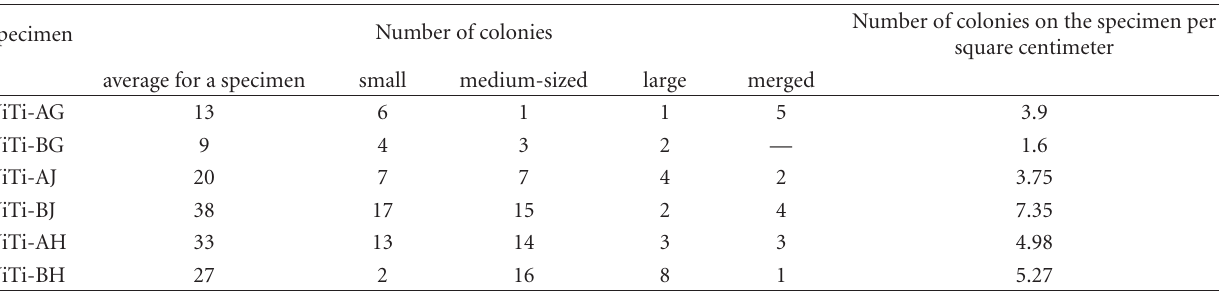
Table 4: E ffi ciency of the formation of colonies of MSCs cultivated on the surface of the NiTi specimens di ff ering in chemical compositions and roughness. Summarized data for three specimens of each type. Specimen Number of colonies